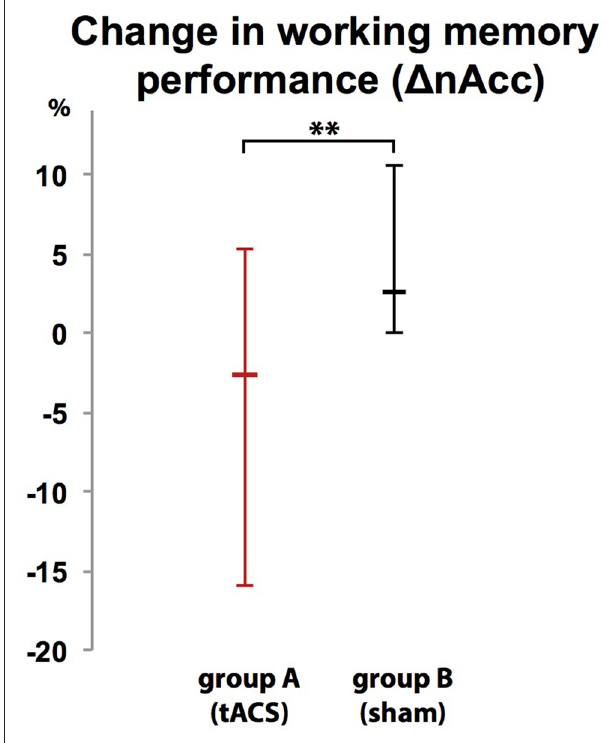
FIGURE 7 | Group-dependent difference in WM performance as measured as difference in correct responses in a 2-back task between a baseline block (block 1) and interventional block (block 2) . WM performance dropped when tACS was applied (group A) but not during sham stimulation (group B). Error bars indicate 95% confidence intervals. ∗∗ p <